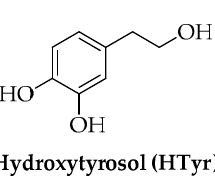
Figure 1. Chemical structure of hydroxytyrosol